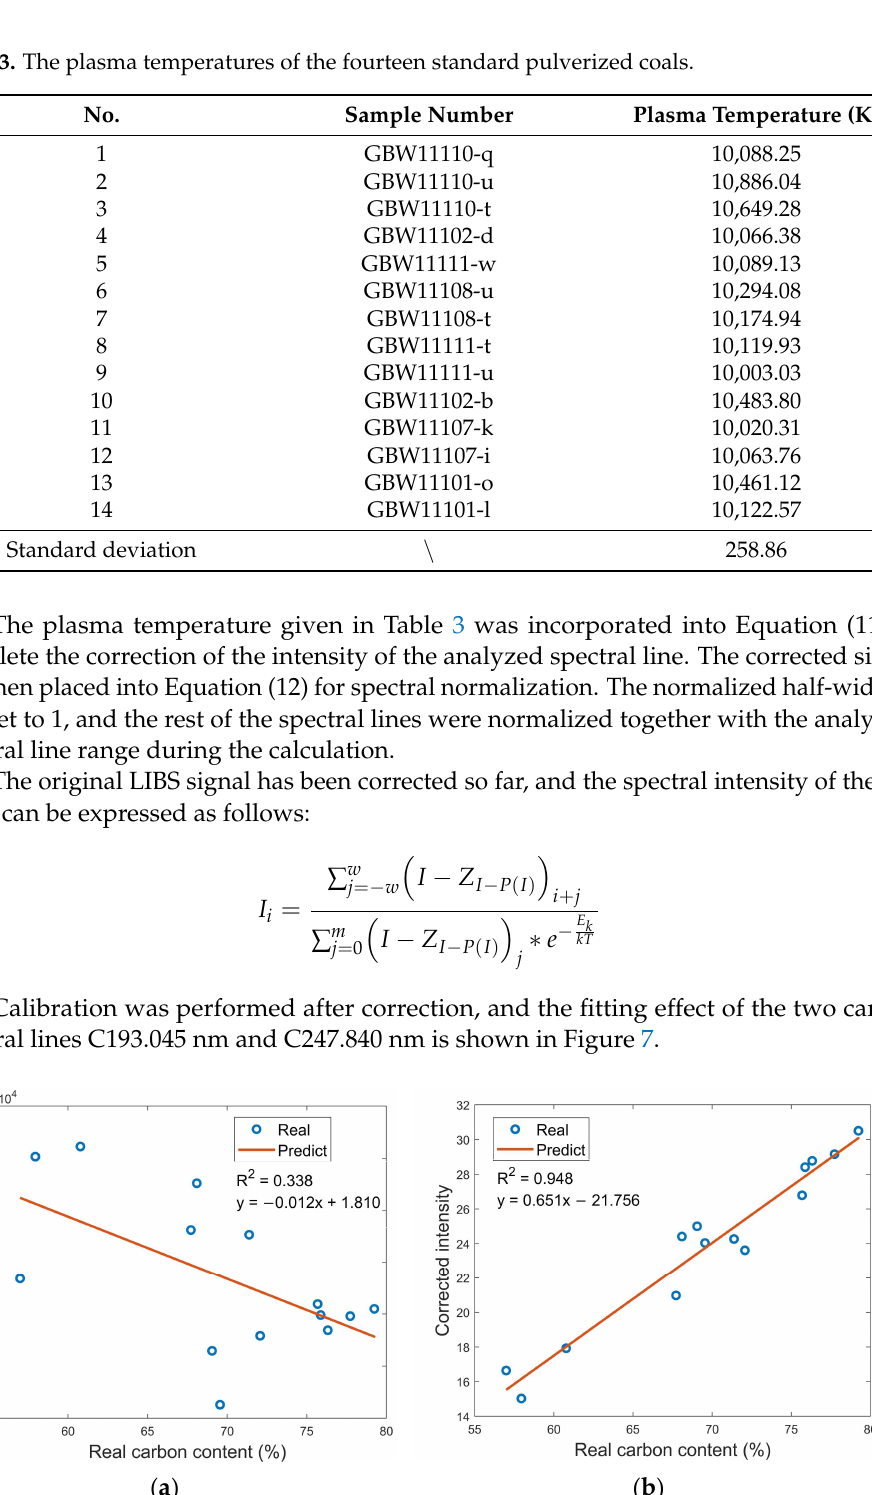
( b ) Figure 8. Plot of the fitting effect of C247.840 nm after P-airPLS method. ( a ) The goodness of fit for original data; ( b ) goodness of fit for processed data. 4.2. Predictive Effect of the Model This paper utilized one coal sample as the prediction sample and the other thirteen coal samples for modeling to validate the prediction effect of the dual-spectrum correction